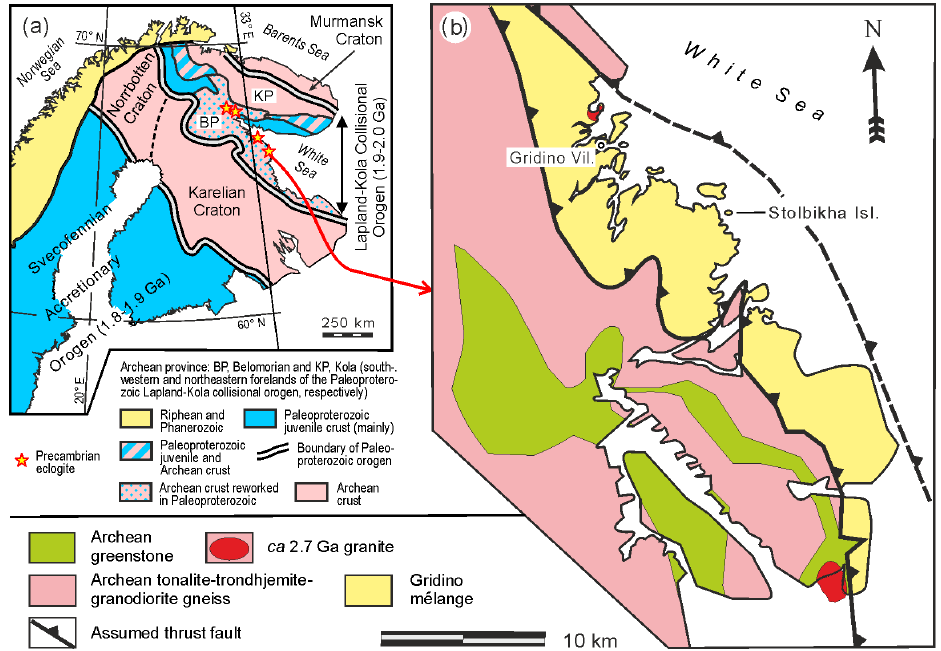
Figure 1. ( a ) Major tectonic units of the Fennoscandian Shield and location of Early Precambrian crustal eclogites (modified from [27]). ( b ) Geological sketch map of the Gridino study area show- ing the Gridino eclogite-bearing mélange (modified from [27]) and the location of Stolbikha Island where the studied eclogites are